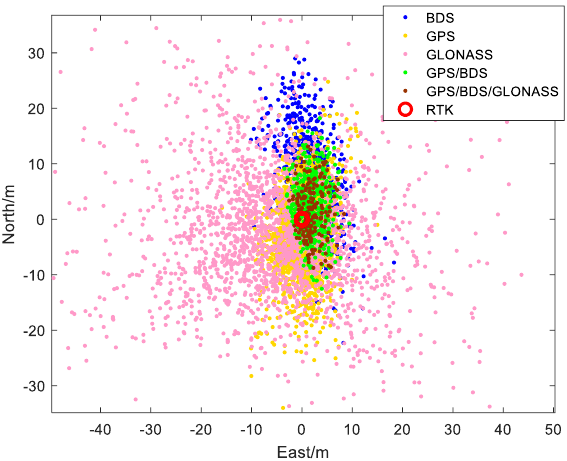
Figure 6 . Static smartphone positioning results based on BDS and GPS satellite systems and their combination. The blue points are the single-point positioning results of BDS. The yellow points are the single-point positioning results of GPS. The pink points are the single-point positioning results of GLONASS. The green points are the single-point positioning results of the combination of GPS and BDS. The brown points are the single-point positioning results of the combination of GPS, BDS, and GLONASS. The red circle is the average RTK result of the one-hour static experiment.